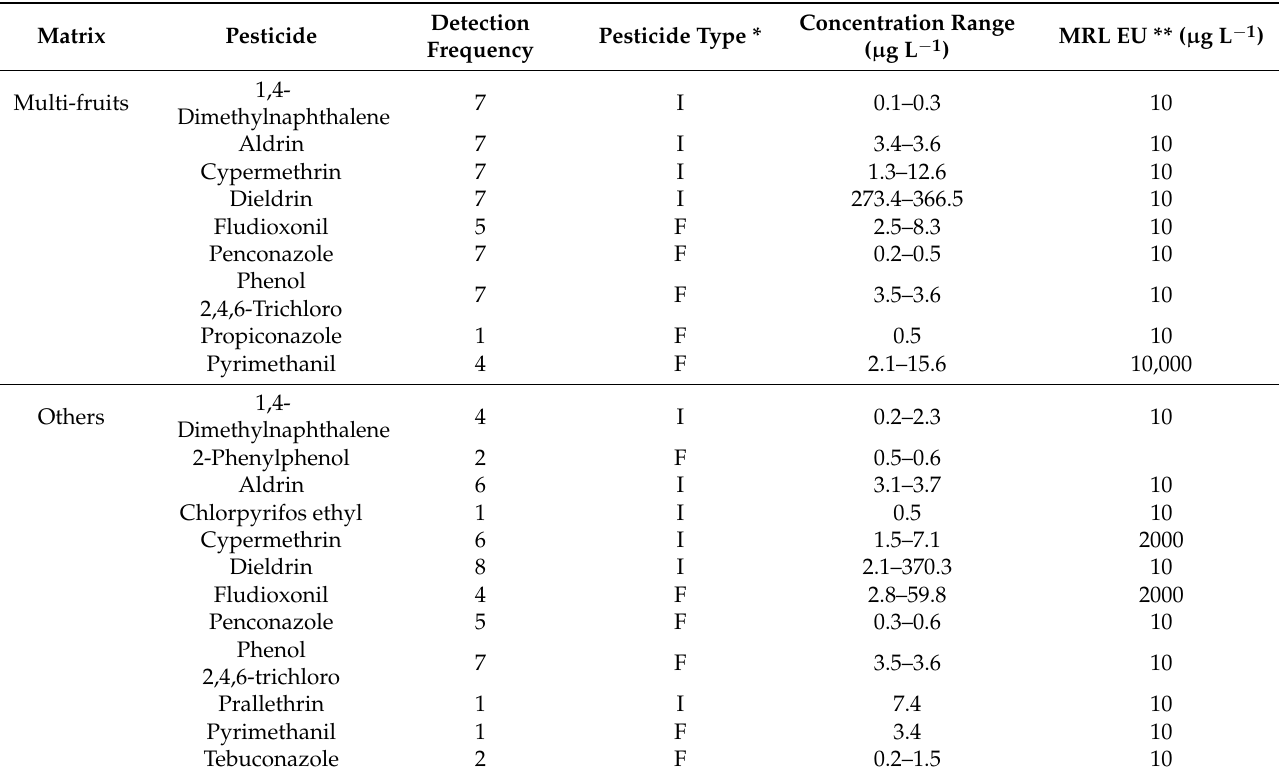
Table 2. Pesticide residues detected in juice